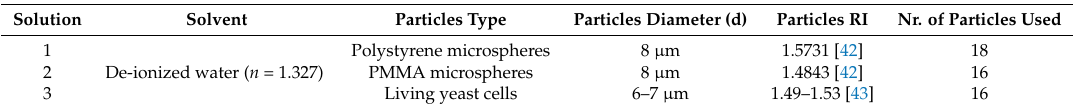
Table 1. Optical and morphological characteristics of the particle samples used in the experiment. RI-Refractive Index. Nr.—Number.